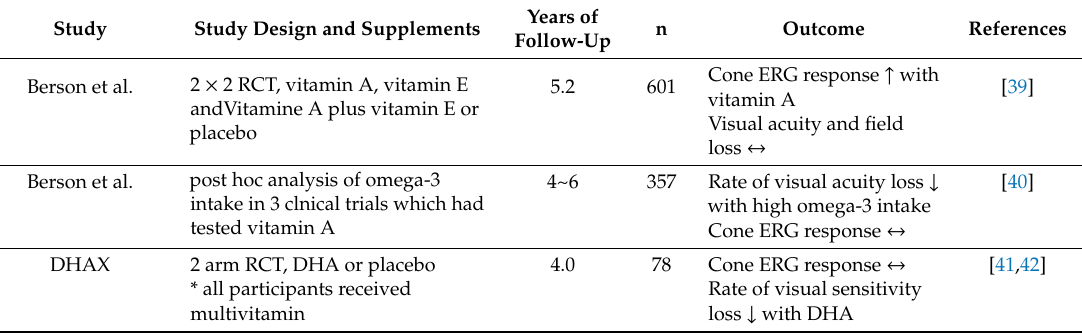
Table 2. Treatment outcomes of anti-oxidant supplements in retinitis